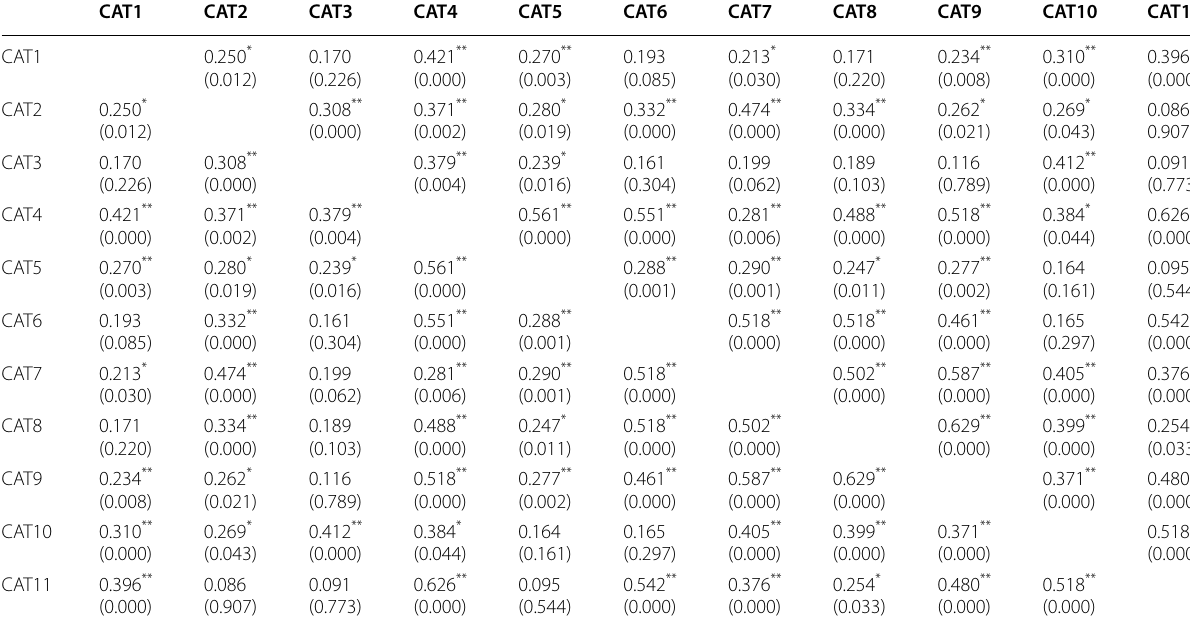
CAT1 number of authors, CAT2 period of publication, CAT3 journal ranking, CAT4 research topic, CAT5 feature of FLA, CAT6 total number of publications, CAT7 total number of journal article publications, CAT8 total number of independent citations, CAT9 Hirsch Index, CAT10 ever co (authored) FS article in Q1 journal?, CAT11 ever co (authored) FS article in Futures